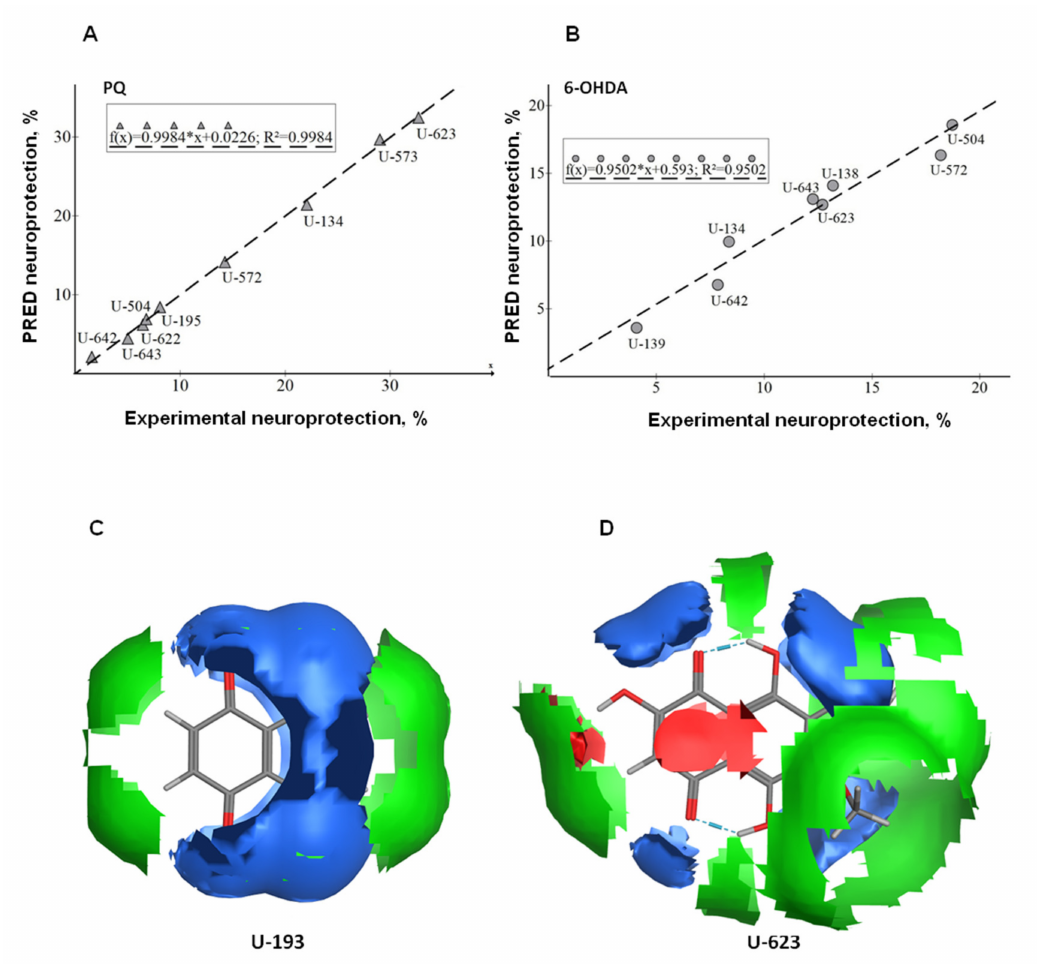
Figure 5. Predicted neuroprotective activity (%) of basic 1,4-NQs (0.1 µ M) as a function of experimental values for the Neuro-2a cell line in the presence of PQ ( A ) or 6-OHDA; ( B ) the electrostatic feature map predicting electrostatically preferred locations of hydrophobic, H-bond acceptor, and H-bond donor locations for non-active U-193 ( C ) and highly active neuroprotective U-623 ( D ). Data on experimental cytoprotective activity were obtained using the MTT method (Figure 1). The colour value for the isocontour surface of a particular interaction atom type is green—hydrophobic; blue— donor; red—acceptor interaction atom types. The maps are displayed for the default energy values (in kcal/mol) of − 0.4 for the hydrophobic map and − 2 for H-bond acceptor and H-bond donor